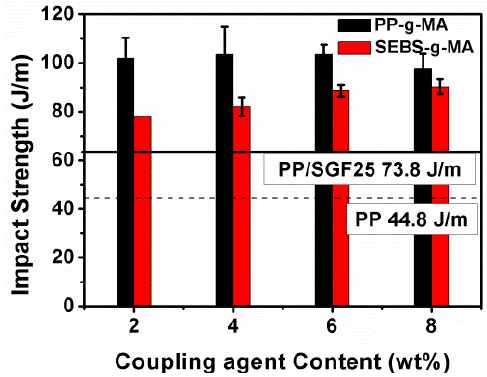
Figure 3. Impact strength of PP/SGF composites, as related to various coupling agents. Table 3. Variations in tensile, flexural, and impact properties in percentage (%).